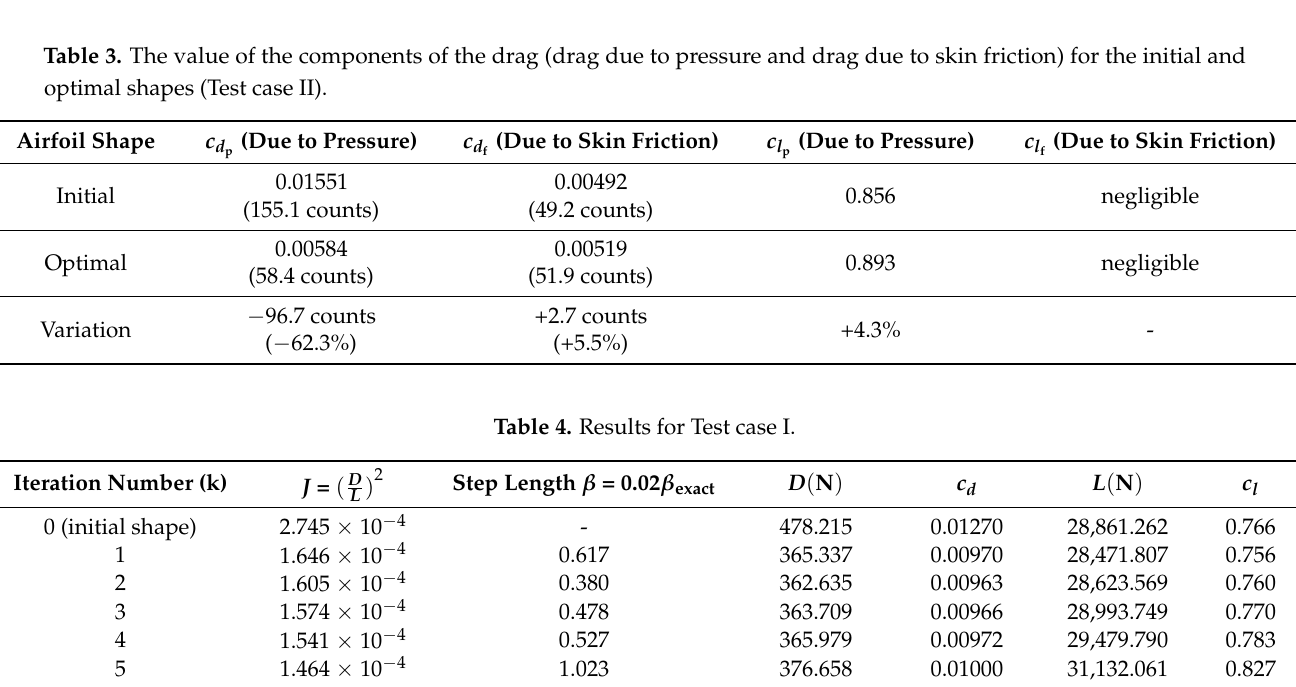
Table 5. Results for Test case II.